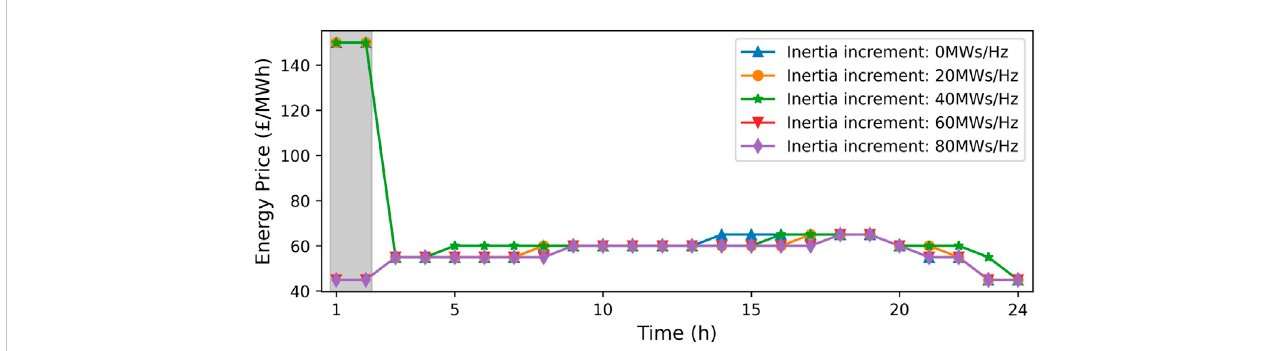
FIGURE 4 Impact of inertia increment on energy prices.